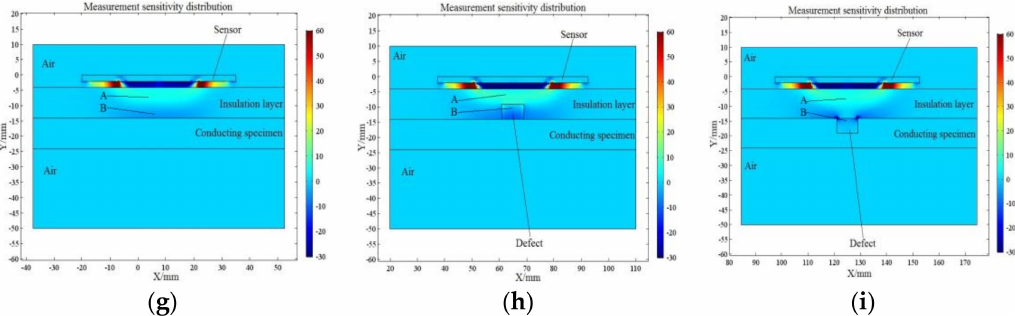
Figure 5. Measurement Sensitivity Distribution (MSD) diagrams of the multi-electrode sensor: E21 inspecting the specimen without defects ( a ), the defect located in the insulation layer ( b ) and the defect located on the surface of the conducting specimen ( c ); E31 inspecting the specimen without defects ( d ), the defect located in the insulation layer ( e ) and the defect located on the surface of the conducting specimen ( f ); E41 inspecting the specimen without defects ( g ), the defect located in the insulation layer ( h ) and the defect located on the surface of the conducting specimen ( i